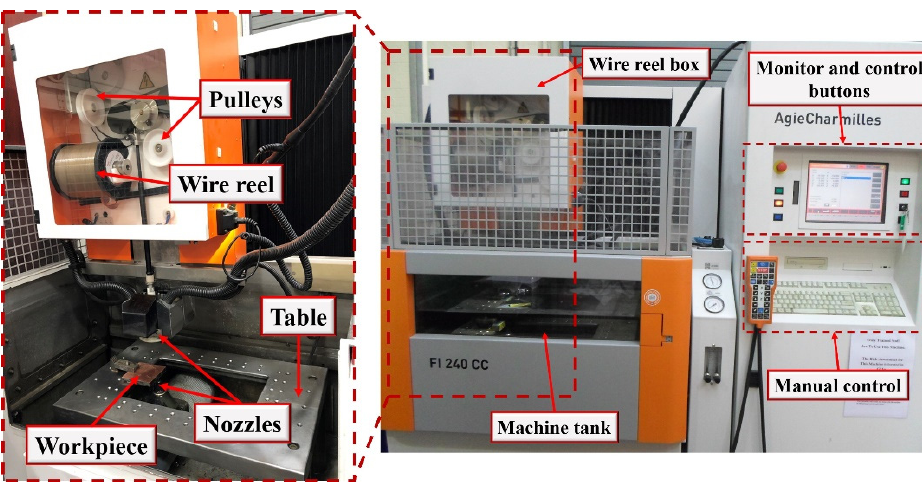
Figure 3. AgieCharmilles Robofil FI240cc wire EDM machine.